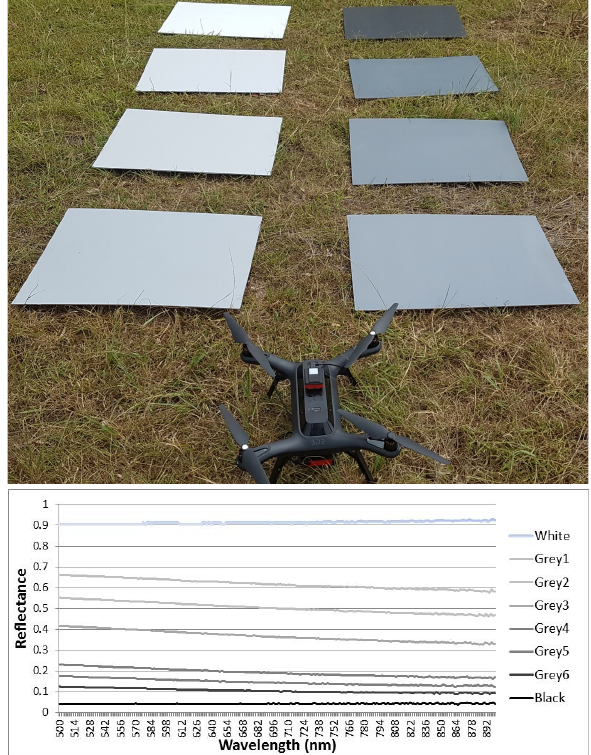
Figure 3. Eight radiometric calibration targets and corresponding reflectance signatures between 500 and 900